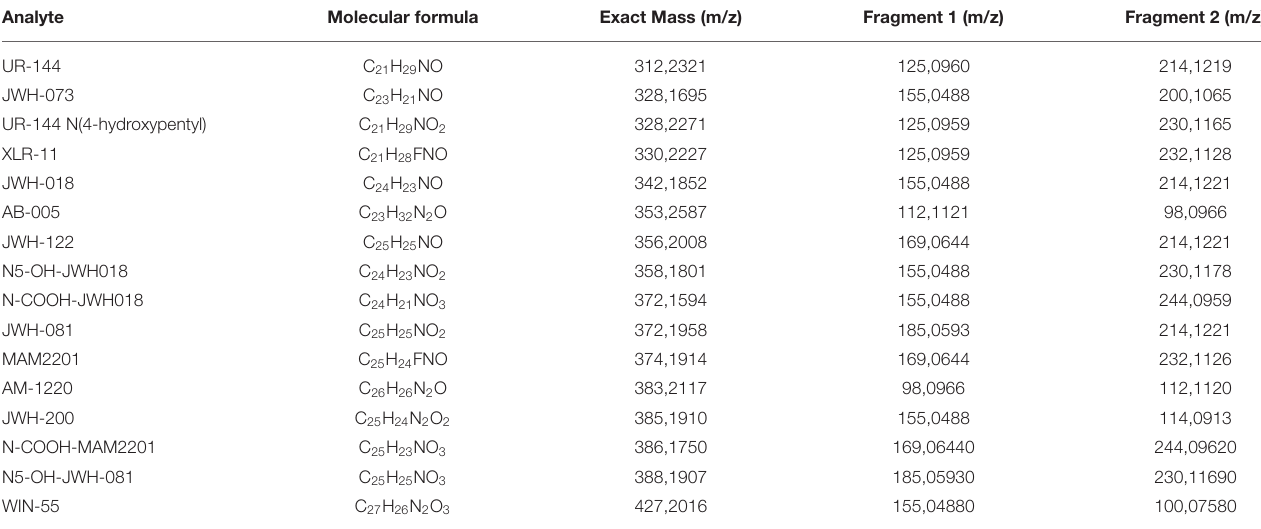
TABLE 1 | List of synthetic cannabinoids included in the standard mixture. Analyte